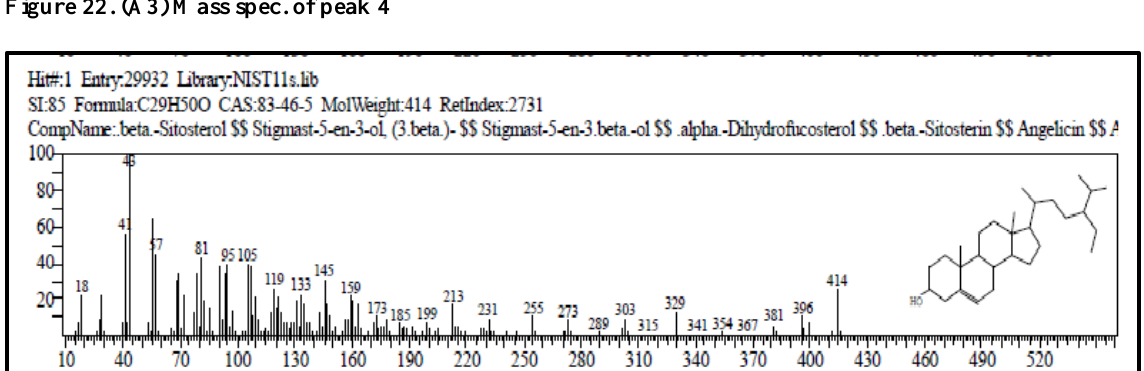
Figure 22. (A3) Mass spec. of peak 4